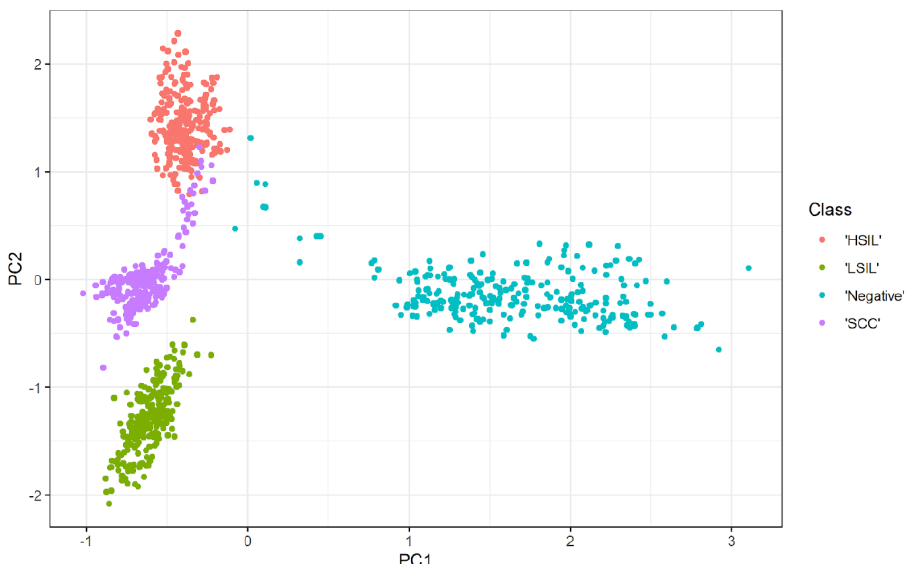
Figure 6. Scatter plot showing the first two principal components and how they visually discriminate between the four classes. The figure shows the effectiveness of separation between classes after selecting the most representative components using PCA.